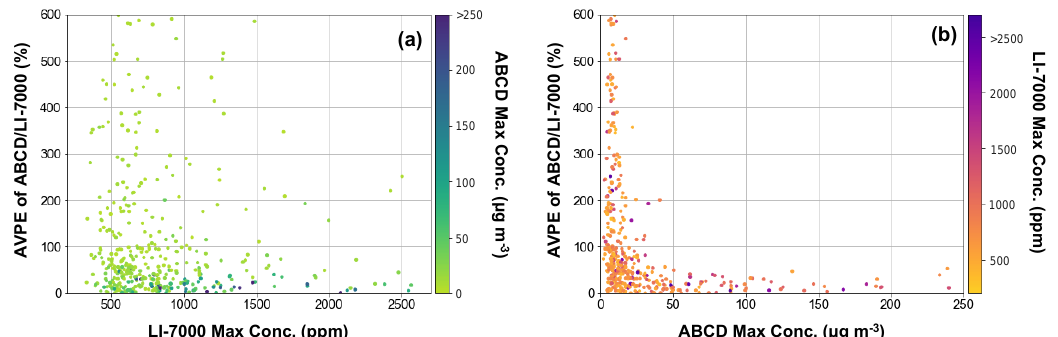
Figure A7. Percent error of emission factors measured using the ABCD / LI-7000 as compared to emission factors measured using the AE33 / LI-7000, plotted versus ( a ) LI-7000 CO 2 and ( b ) ABCD BC peak maximum concentrations. Data shown are from measurements made at the Arterial Road in 2020.